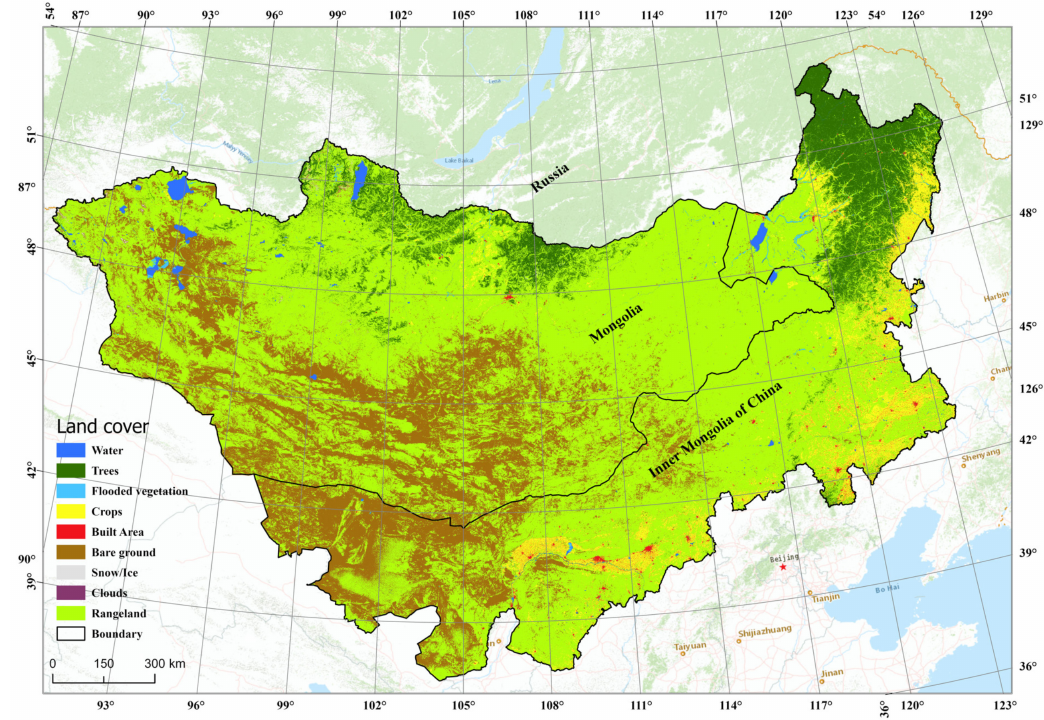
Figure 1. Land cover pattern in the Mongolian Plateau (MP).